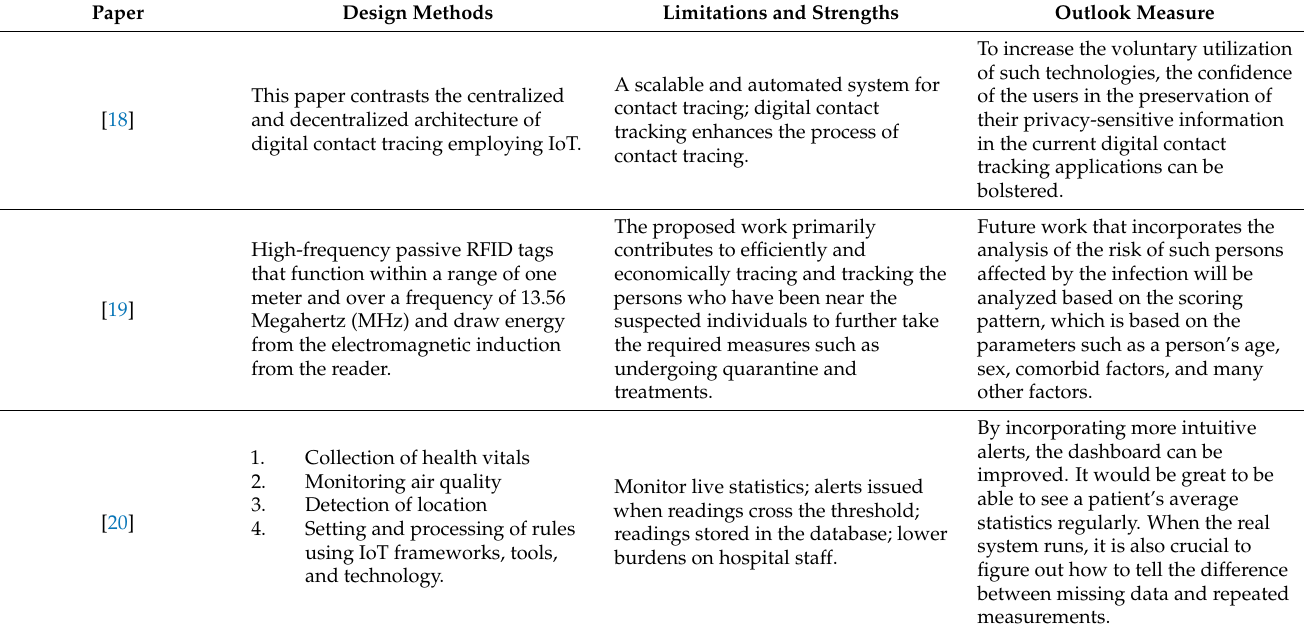
Table 1. Summary of related